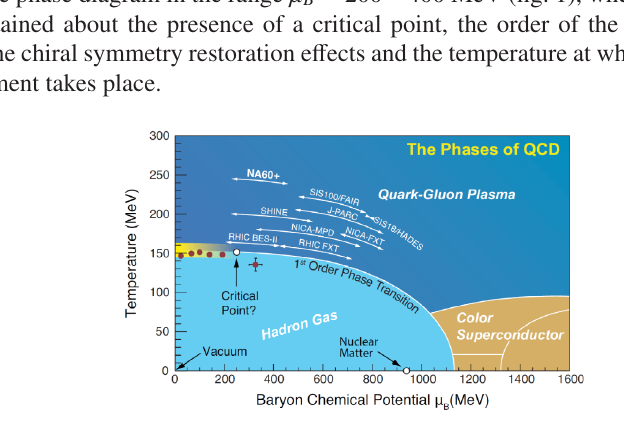
Figure 1. The QCD phase diagram (courtesy of Thomas